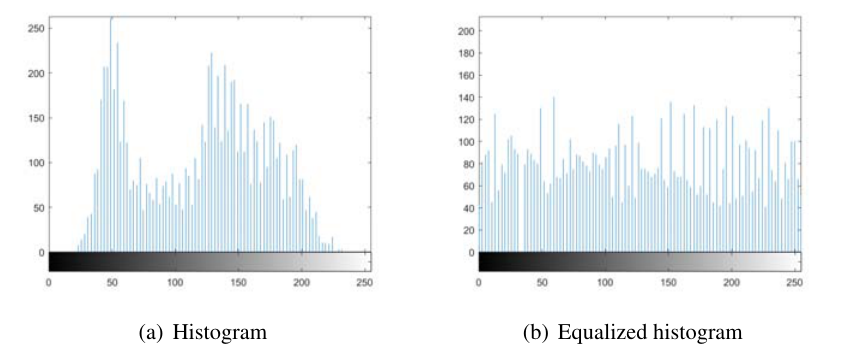
Fig. 3 Histogram of a gray-scale image of Lenna and the histogram of the resulting image after having applied